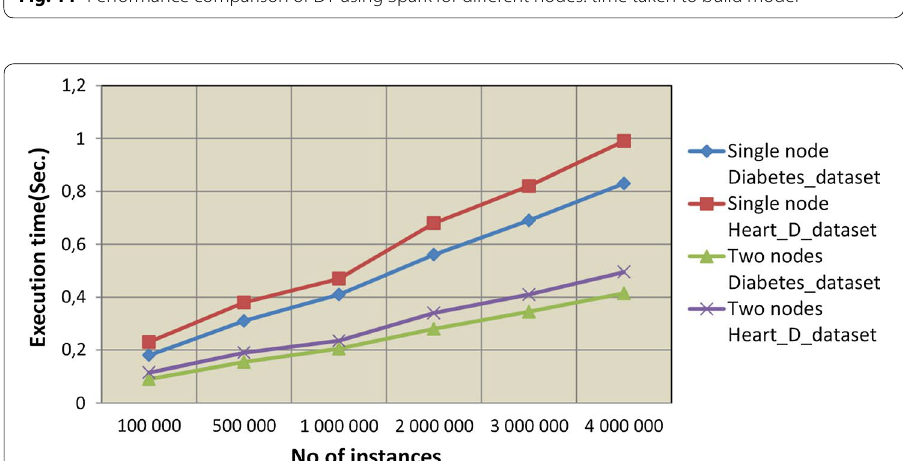
Fig. 11 Performance comparison of DT using Spark for different nodes: time taken to build model